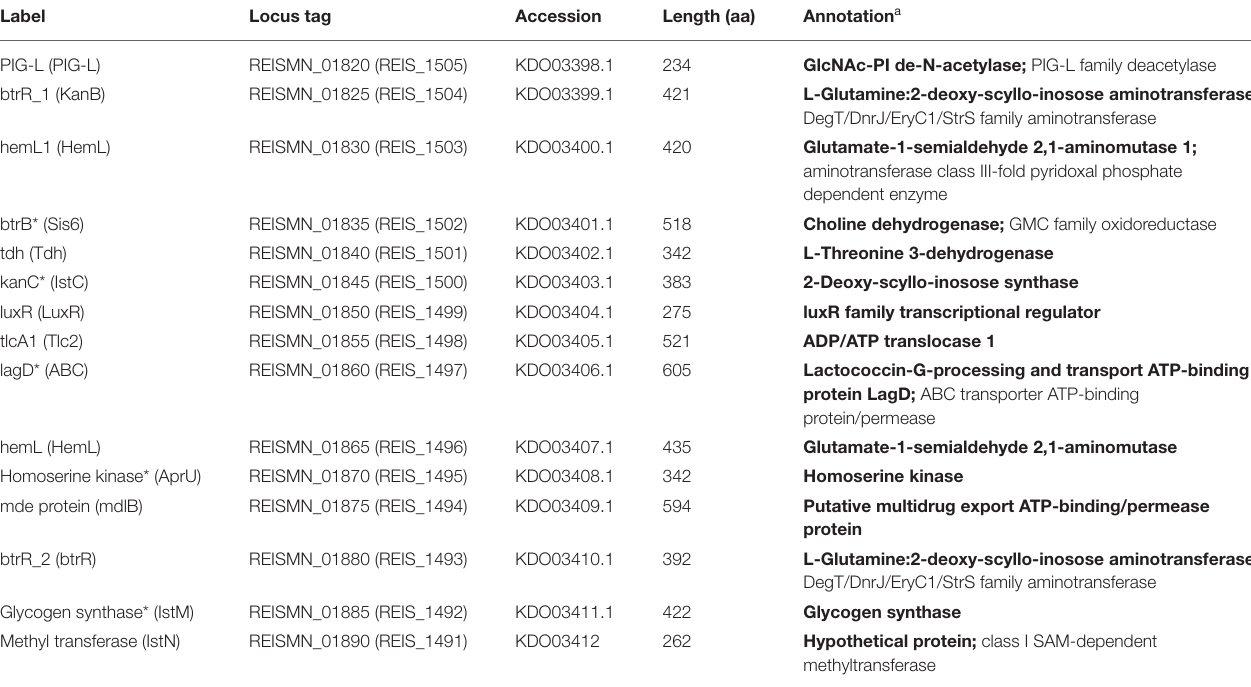
Asterisks indicate genes with transcription confirmed by RT-PCR. Protein labels and locus tags for corresponding genes in the REIS (Wikel) genome are shown in brackets. a Bold type indicates annotation recorded in the genome; regular type indicates additional annotations gained through protein BLAST